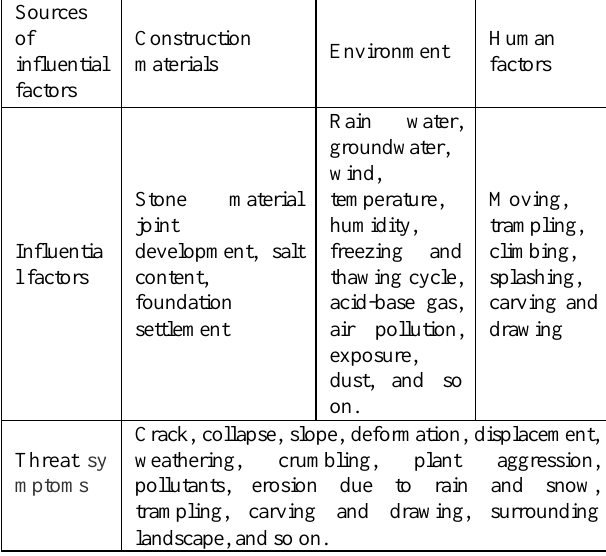
Table 2 Threats and Influential Factors of the